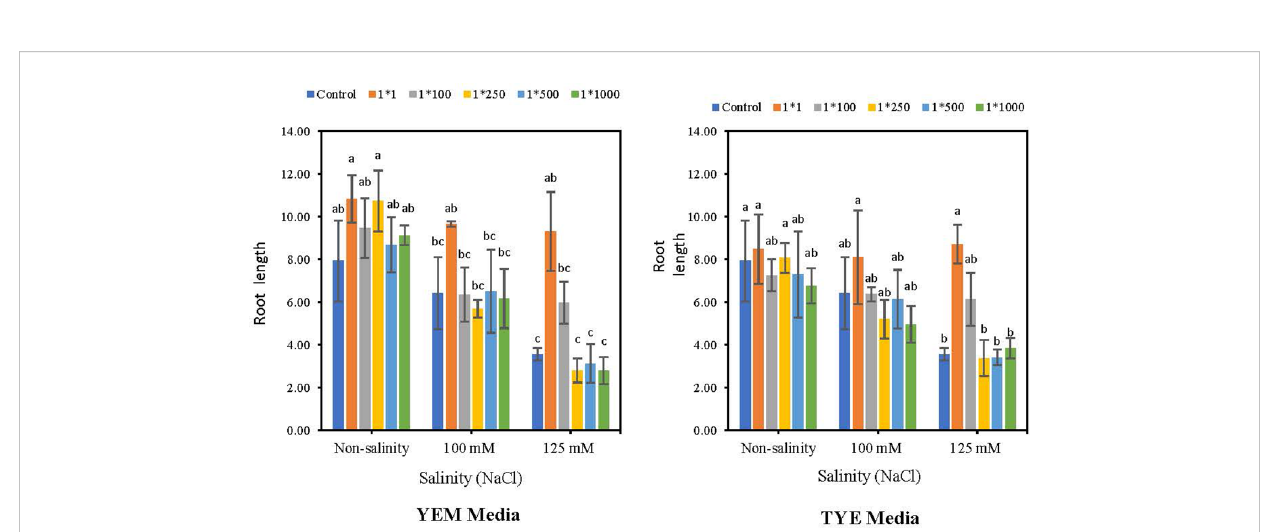
FIGURE 7 Effect of dilutions of Devosia sp. YEM(B)-CFS and TYE(B)-CFS and salinity on root length of soybean. Values represent the mean of four replicates ± SD. 1:1, 1:100, 1:250, 1:500 and 1:1000 = 1 mL Devosia sp. CFS and 1, 100, 250, 500 and 100 mL distilled water, respectively.